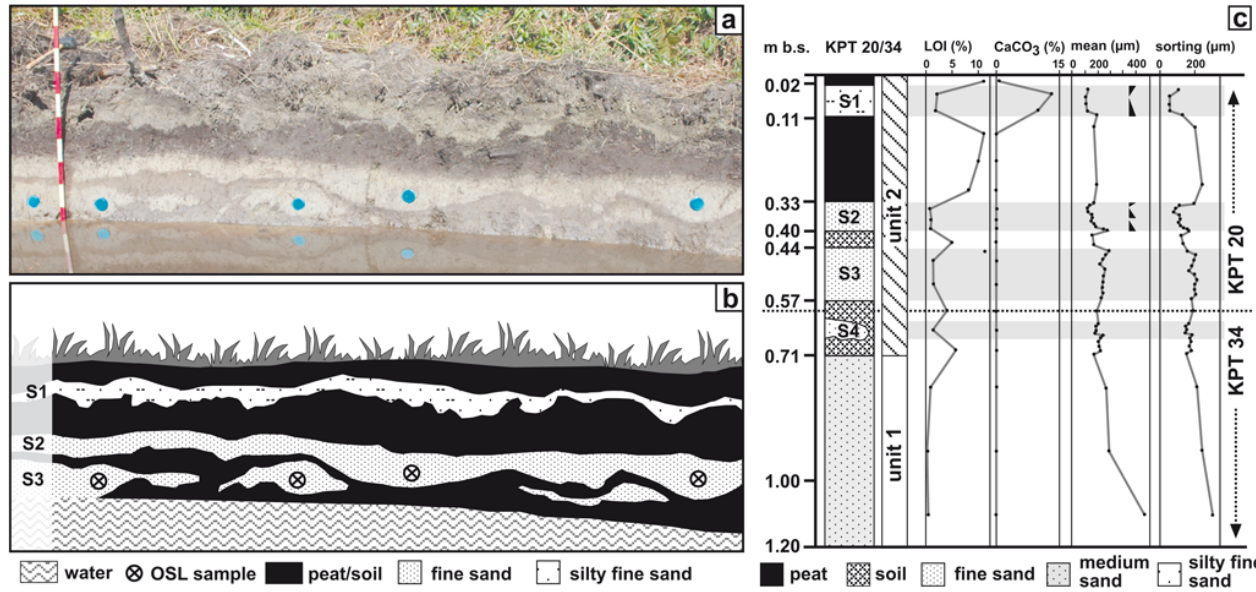
Fig. 4. Combined stratigraphy of trench KPT 20 and core KPT 34 (see Fig. 2b for location). (a) Photograph of KPT 20. Each section of the scale represents 10cm. (b) Schematic profile of KPT 20 (sketch of the profile in a ) with explanations of the sedimentary units. (c) Succession of sediments in profile KPT 20/34 with selected analytical parameters. The succession is representative for all other sites sampled in swale VI. S1–S4 = tsunami deposits.